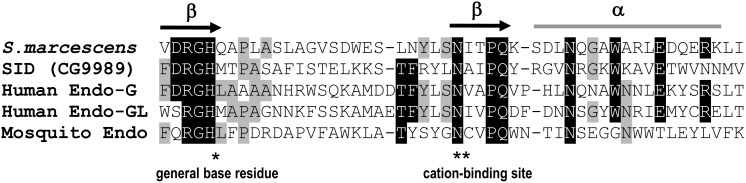
Amino acid sequence alignment of conserved elements among active sites of different nonspecific nucleases.Sequence alignment of the region containing the catalytic-residues of the SmNuc (S.mercescens), SID (Drosophila), two human mitochondrial endonucleases (Endo-G and Endo-GL), and the mosquito CuQu Endo nuclease. The compared nucleases have the conserved RGH motif called the NUC domain that is present in all active family members. The Histidine (*) within the RGH is the general based residue required for catalytic activity while the conserved Asparagine (**) is required for cation binding. Arrows on top of the aligned sequences indicate the two beta sheets and the grey line indicates the position of the alpha helix.